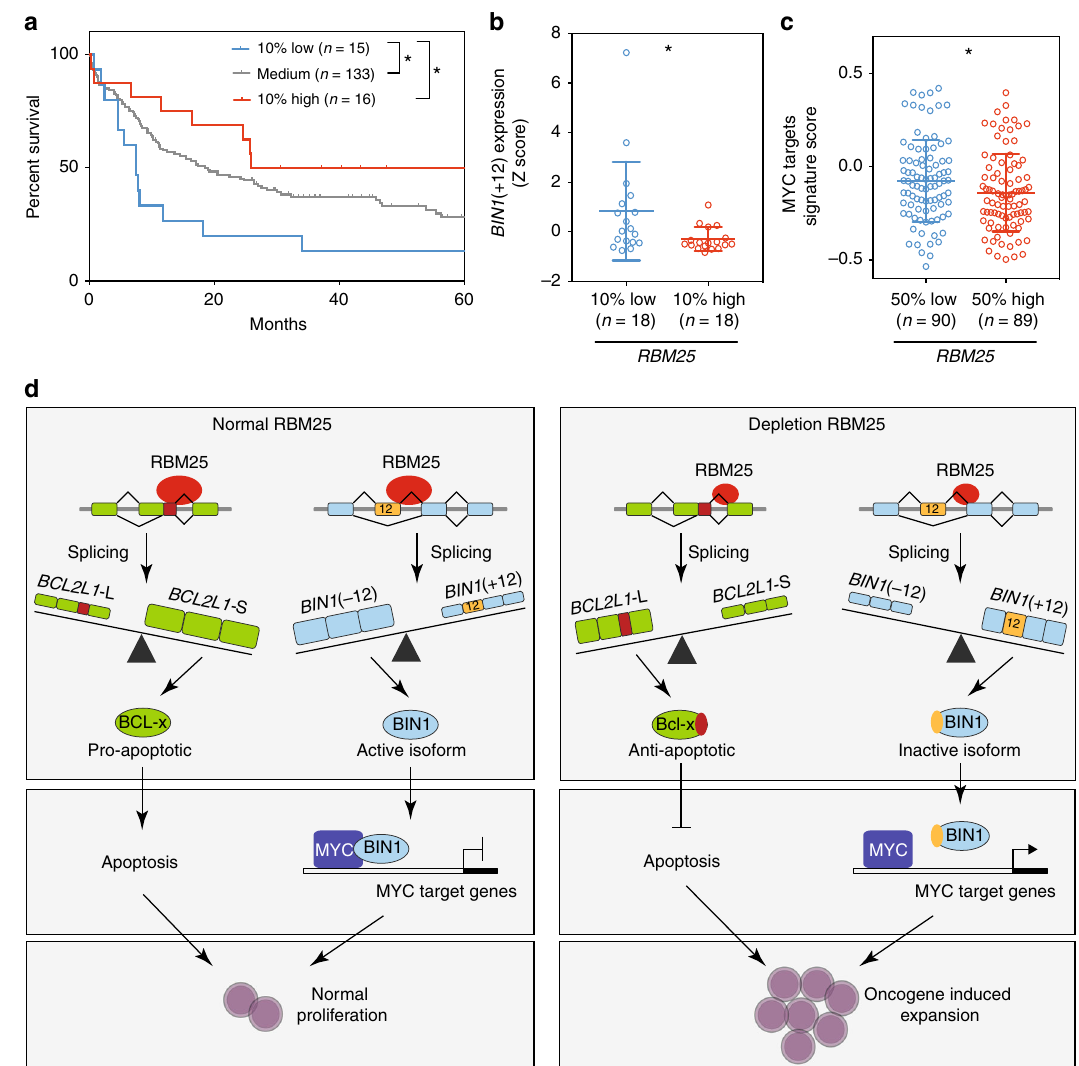
Fig. 8 High RBM25 levels correlate with prolonged patient survival, alternative BIN1 mRNA splicing, and MYC target gene repression. a Overall survival